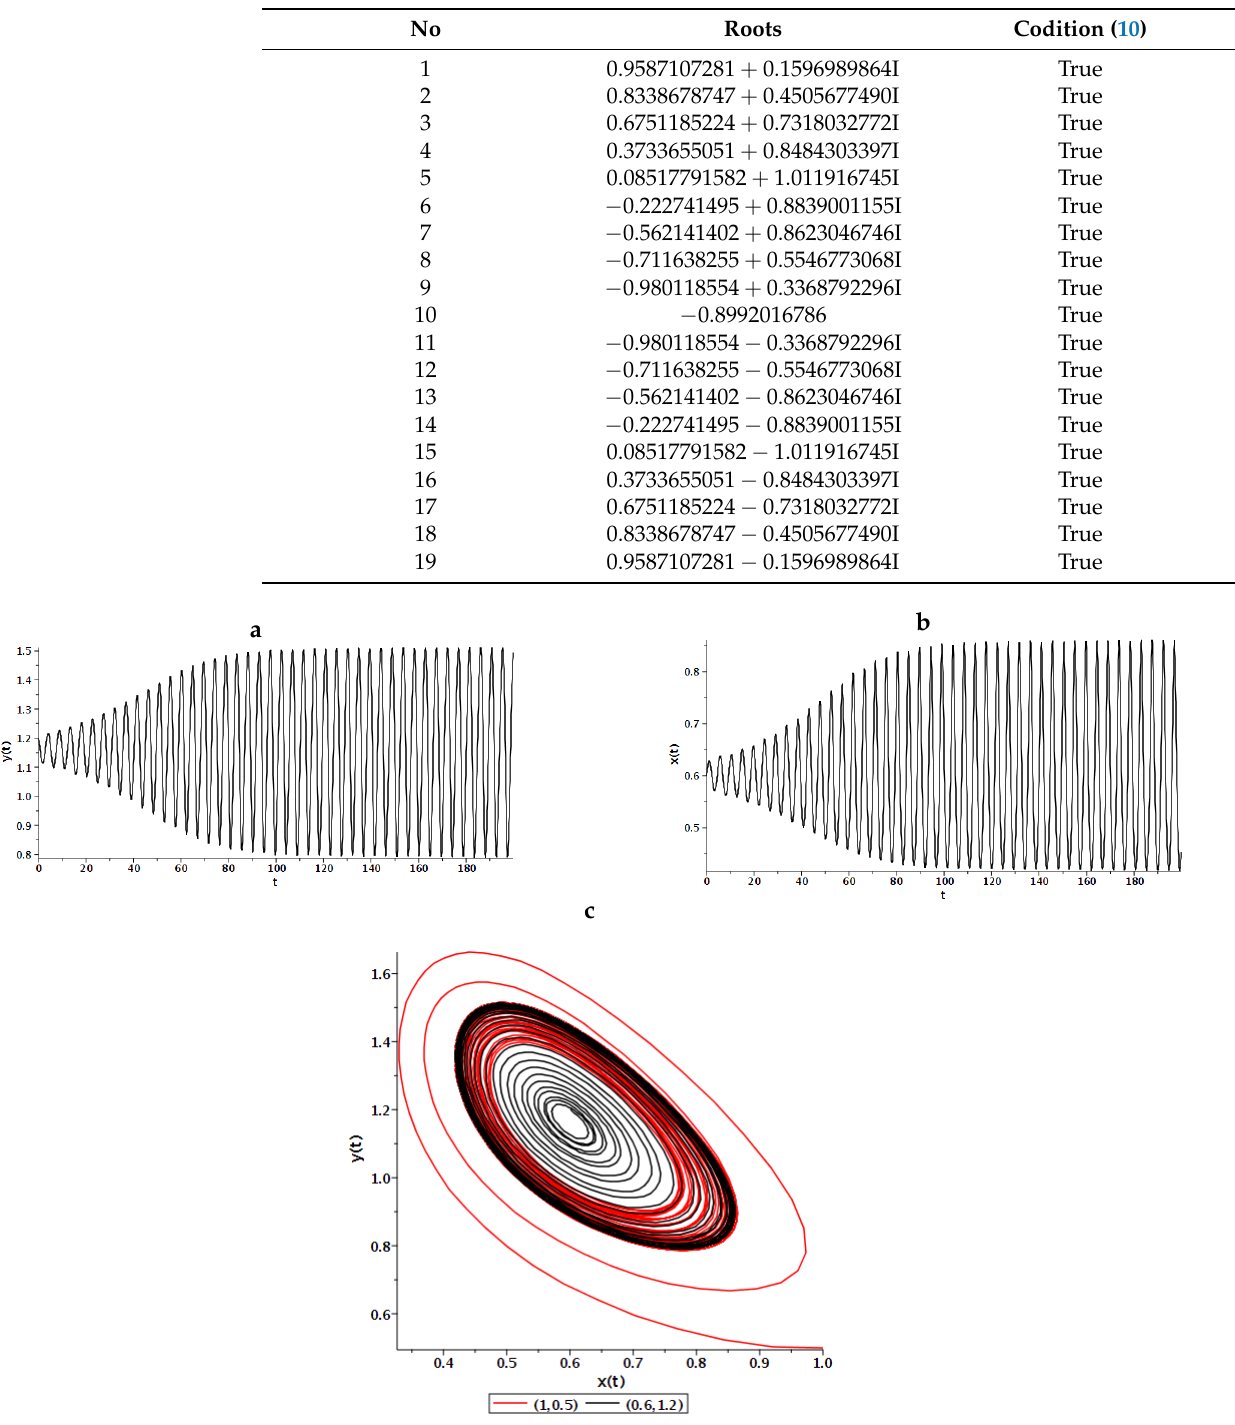
Table 2. Roots of the characteristic equation and their verification for condition (10).